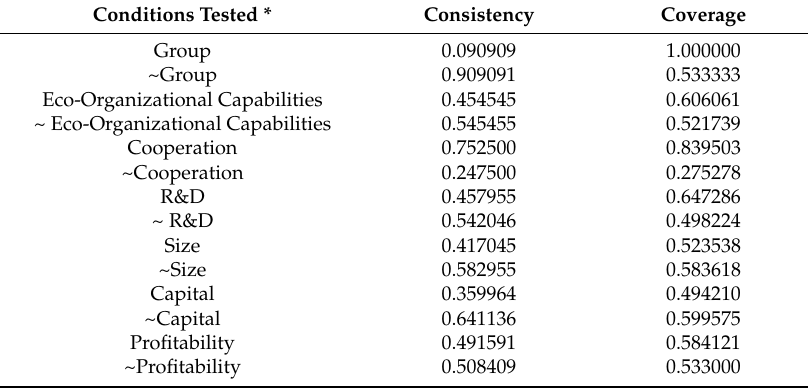
Table 3. Companies that developed internal technological eco-innovations (any type). Analysis of the necessary conditions.